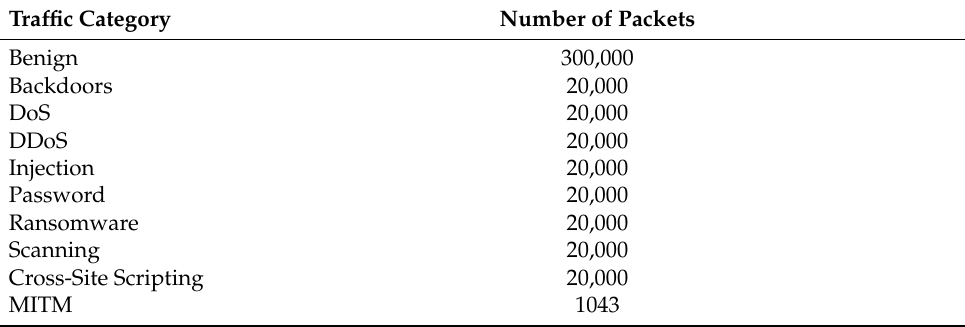
Table 1. Traffic included in the TON_IoT network-based train-test